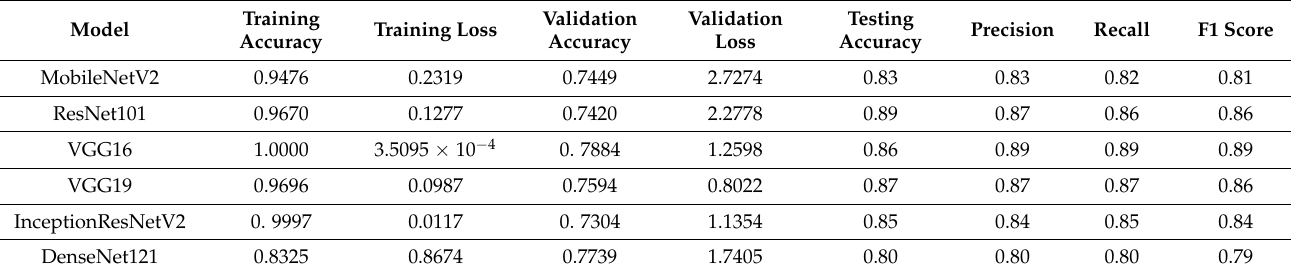
Table 5. Results of different classifiers on Dataset III containing 3